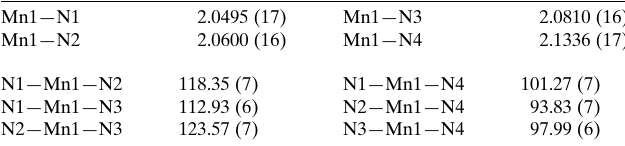
Table 1 Selected geometric parameters (A˚ , (cid:3) ) for compound 1 .